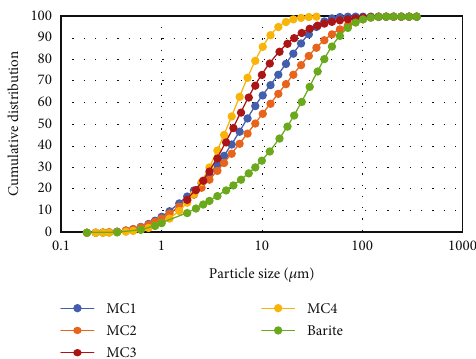
Figure 5: Particle size distribution for the cuttings and weighting material